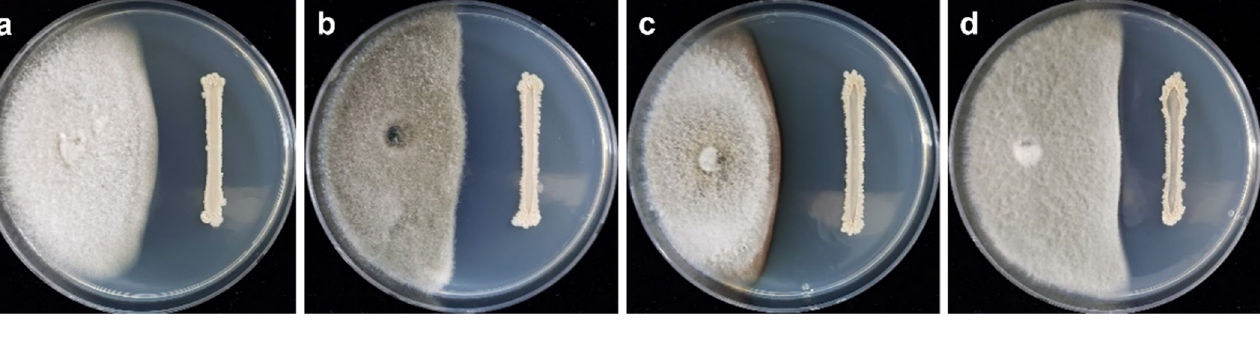
Figure 2. Antagonistic activity of B. velezensis CE 100 against C. acutatum ( a ), C. coccodes ( b ), C. dematium ( c ), and C. gloeosporioides ( d ).